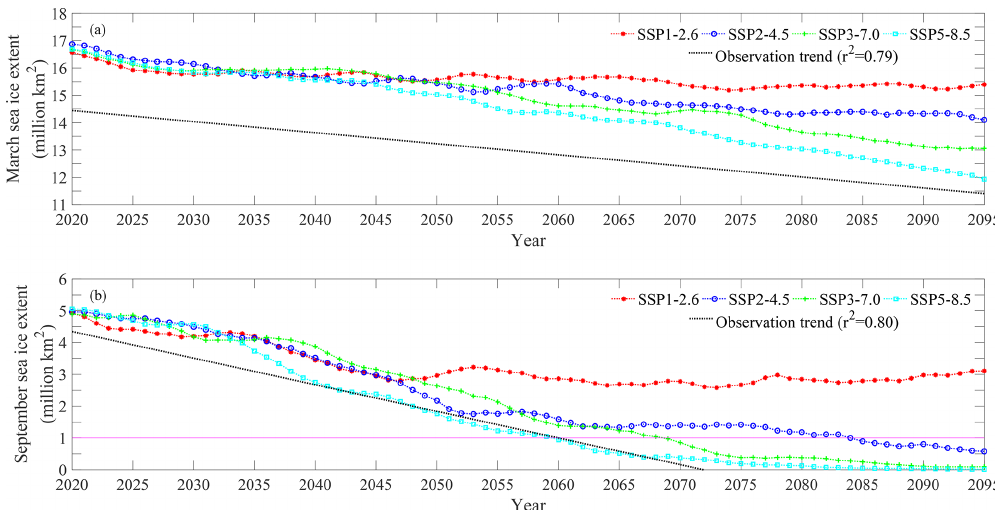
Figure 2. Sea ice extent under multiple scenarios and observation trends in March and